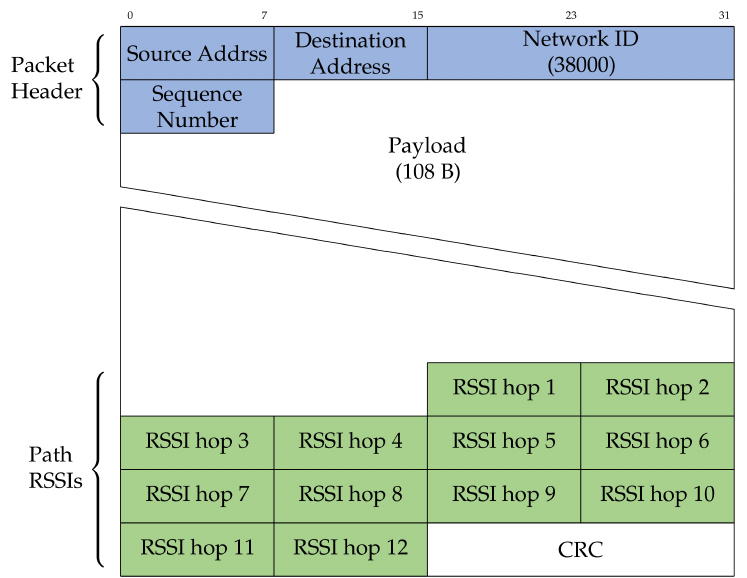
Figure 6. Format of the packet format used. Source and destination addresses are used for hop-by- hop